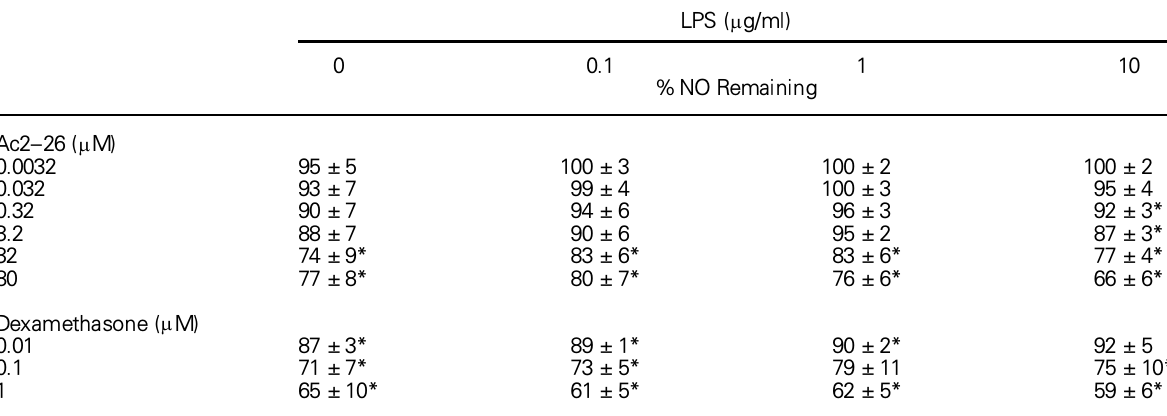
Table 1. Effect of Ac2–26 and dexamethasone on LPS-stimulated NO release. Data are presented as mean ± SEM, and calculated as described in the legend to Fig. 3